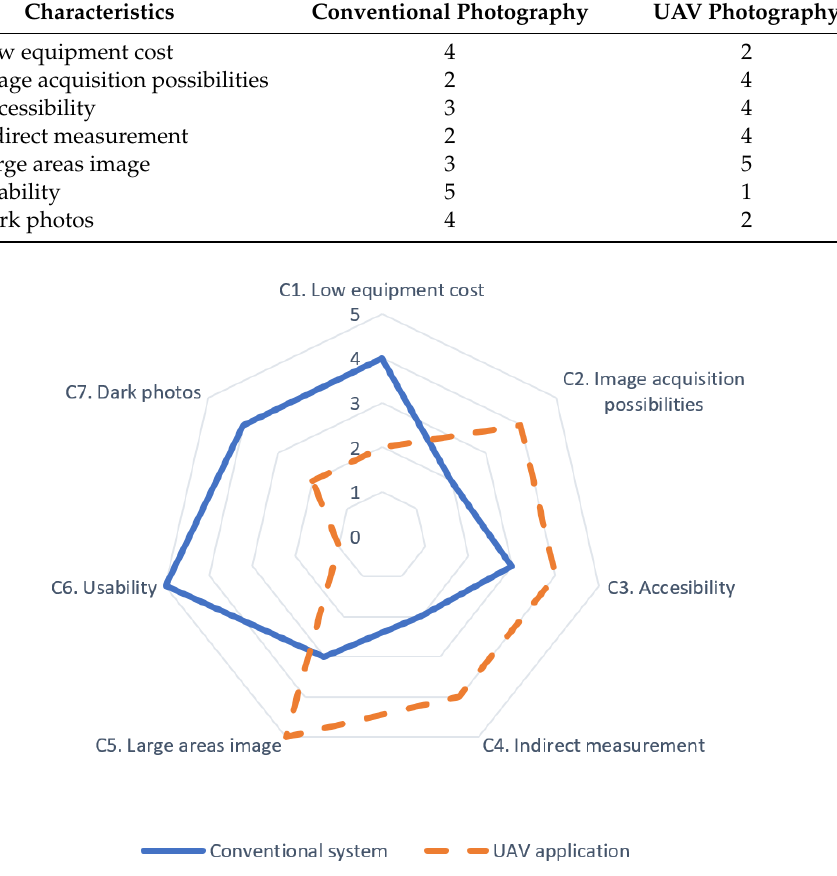
Figure 10. Conventional system and UAV application comparison.